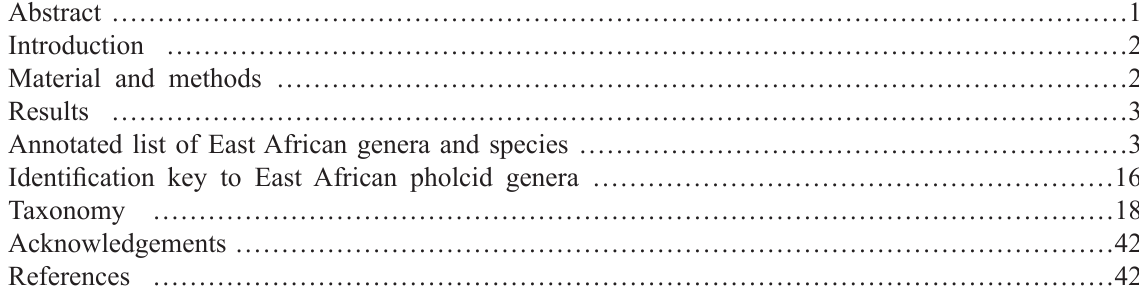
from Yemen, is redescribed based on specimens from Kenya. Additional new records are given for 21 previously described species. Keywords. Pholcidae, East Africa, taxonomy, identification